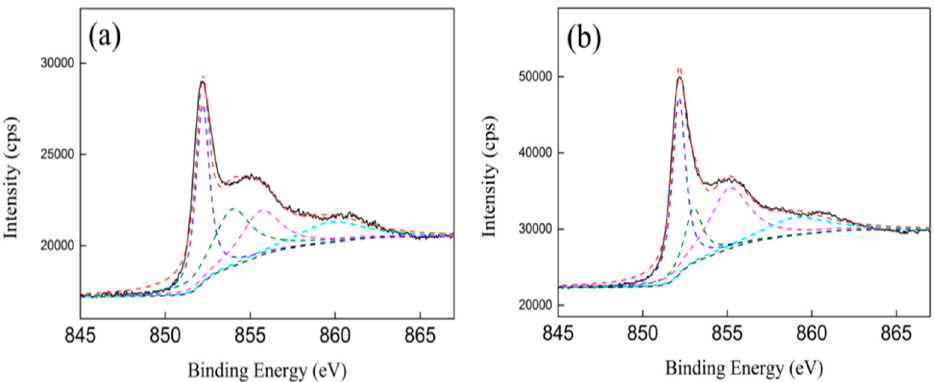
Figure 7. Ni 2p XPS spectra of Ni/ZrO 2 catalysts: ( a ) Ni/ZrO 2 (P) and ( b ) Ni/ZrO 2 (H). Table 3. Binding energy of Ni 2p lines and the corresponding surface concentration of Ni/ZrO 2 catalysts.